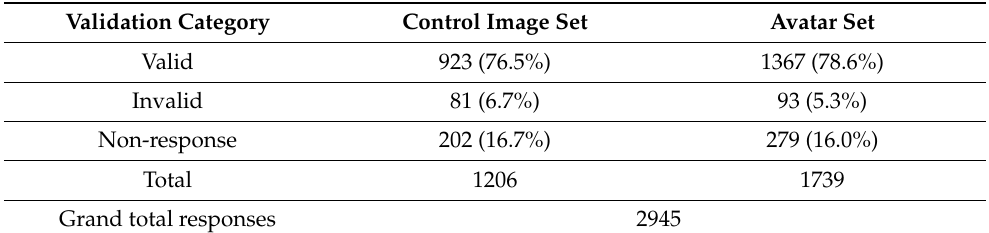
Table 3. Count and percent of valid, invalid, and non-responses to the control image and avatar set